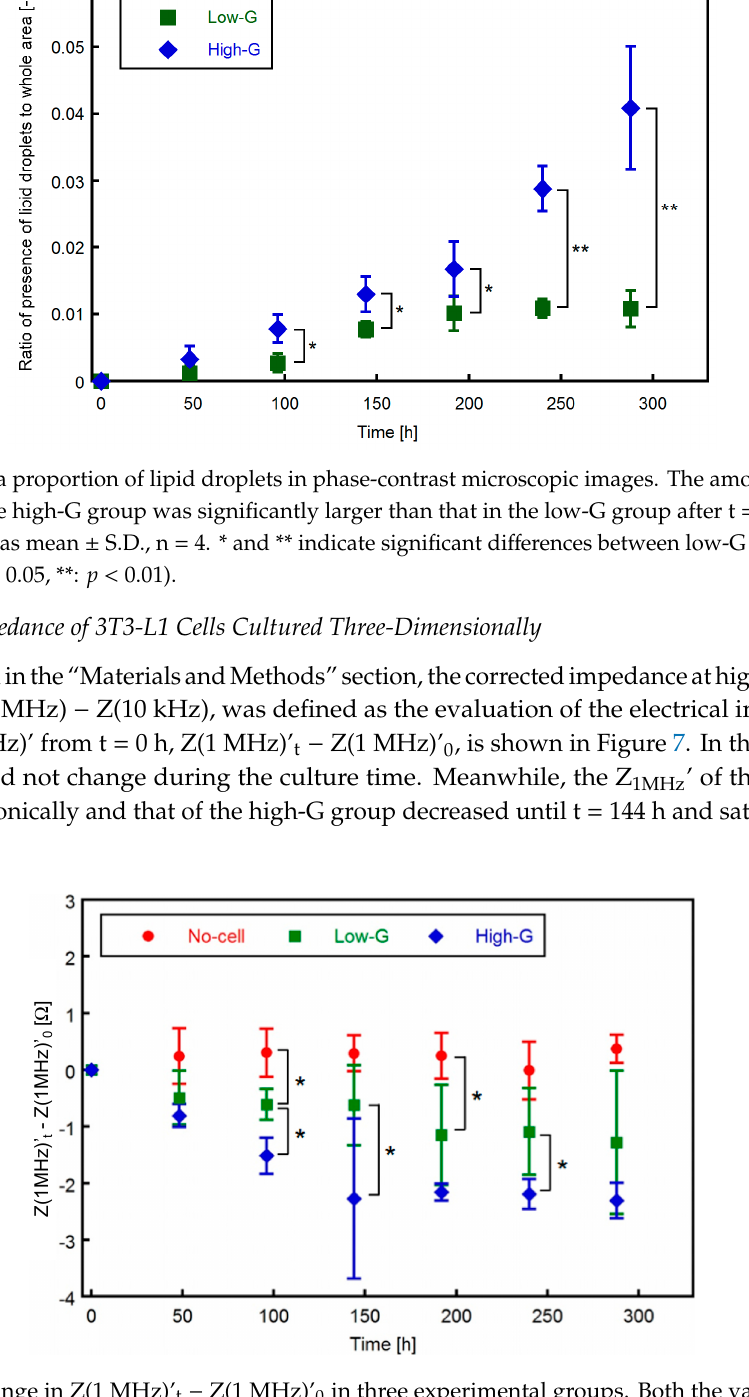
Figure 7. Change in Z(1 MHz)’ t − Z(1 MHz)’ 0 in three experimental groups. Both the values of low and high-G groups decreased with increase in culture time. Data are presented as mean ± S.D., n = 4. * indicates a significant difference between low-G and high-G groups, p < 0.05.